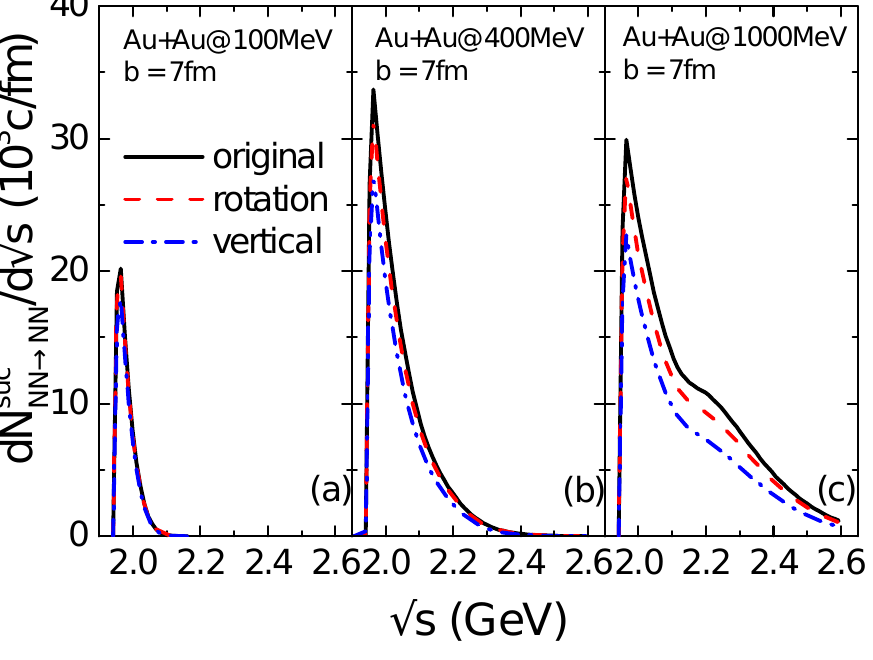
Figure 6. C.M. energy dependence of the successful elastic nucleon–nucleon collision rate from three collision prescriptions in non-central Au+Au collisions at E lab = 100 ( a ); 400 ( b ); and 1000 ( c )